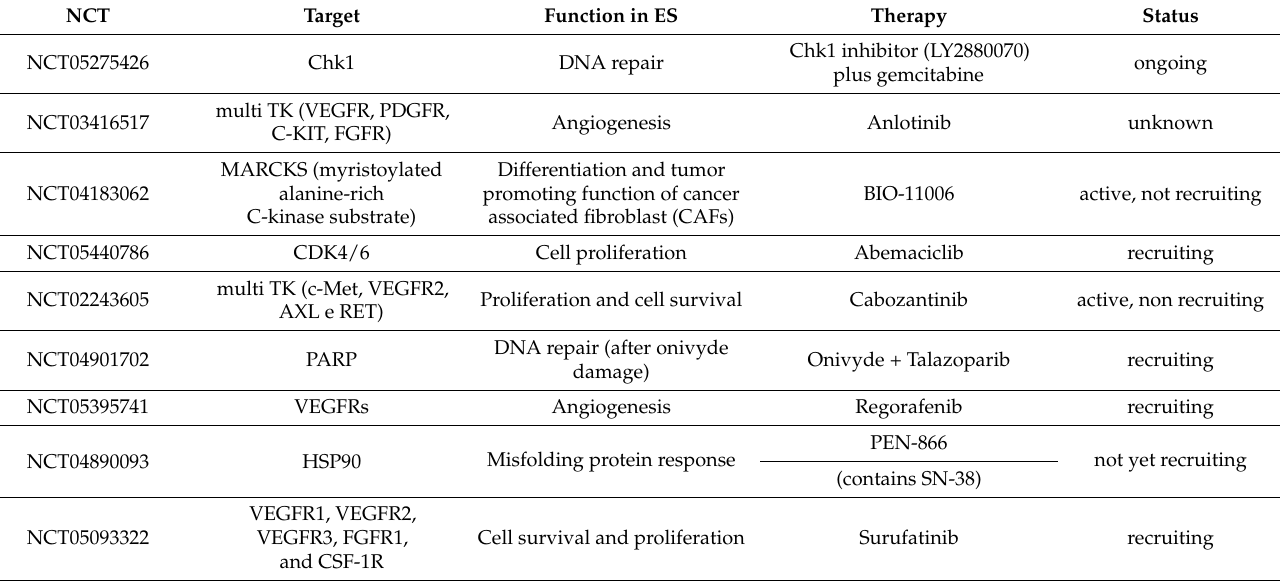
Table 1. Other potential new targets in the treatment of ES that are undergoing pre-clinical and/or clinical investigation for advanced and refractory disease.